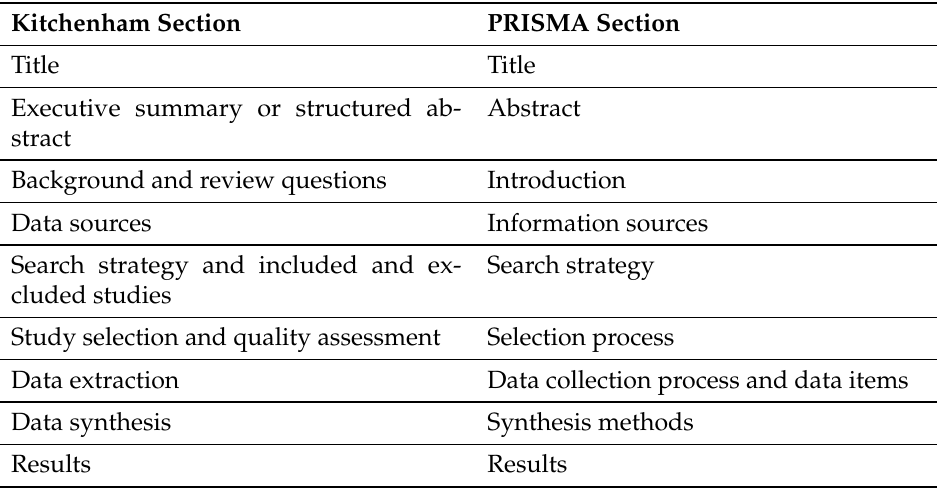
Table 1. The Kitchenham methodology vs. the PRISMA